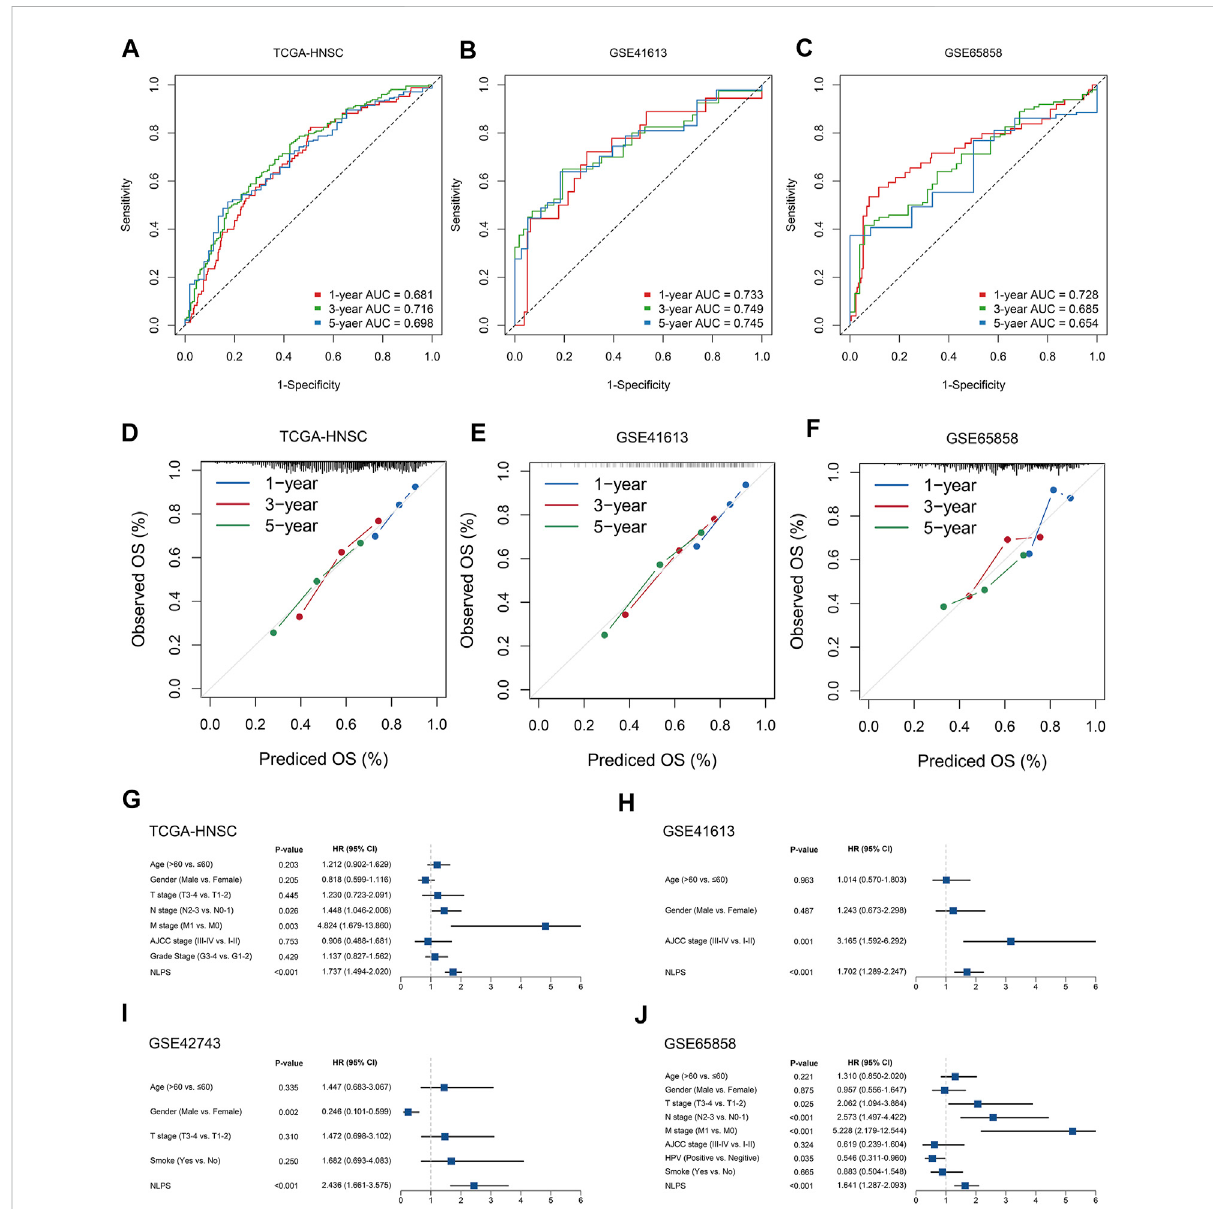
FIGURE 3 The evaluation ofNLPS. (A – C) Kaplan-Meier curves ofOS betweenthetwogroups inTCGA-HNSC (A) , GSE41613 (B) ,and GSE65858 (C) . (D – F) Calibration plots were used to compare the actual probabilities and the predicted probabilities of OS in the three cohorts. (G – J) Multivariate COX regression analysis of the risk